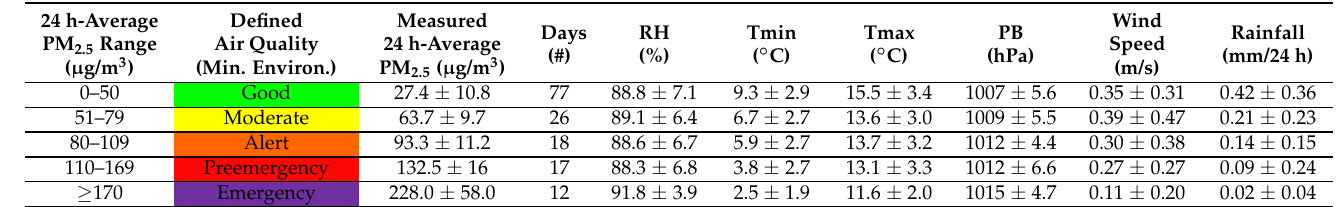
Figure 6. Relationships between PM 2.5 , colored according to the Chilean air quality indexes defined by the Ministry of Environment, and meteorological factors. ( A ) the lowest (minimum) temperature of the day, ( B ) daily average wind speed, and ( C ) rain fall in 24 h. Table 1. Summary of meteorological data, according to the air quality indexes defined by the Chilean Ministry of Environment (Min.